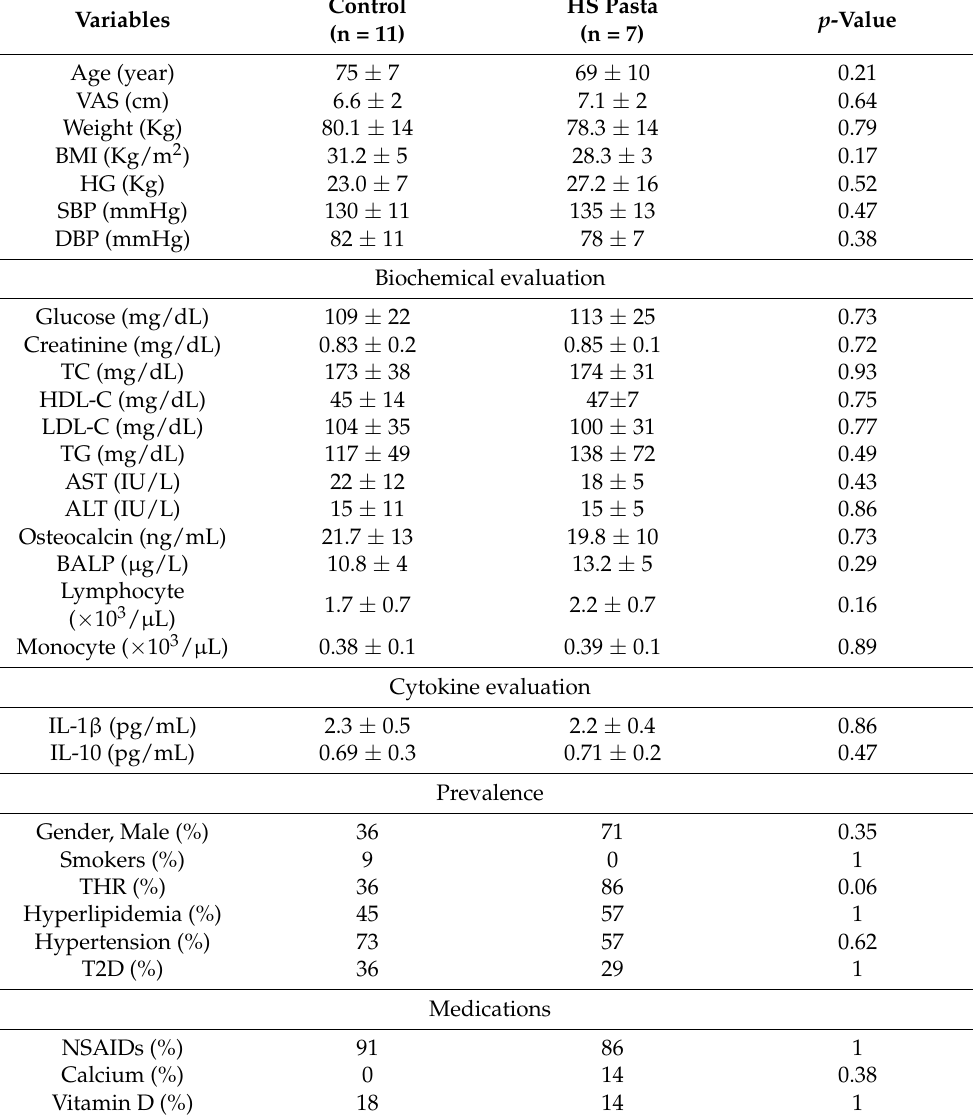
Table 1. Baseline demographic and clinical characteristics of participants according to the